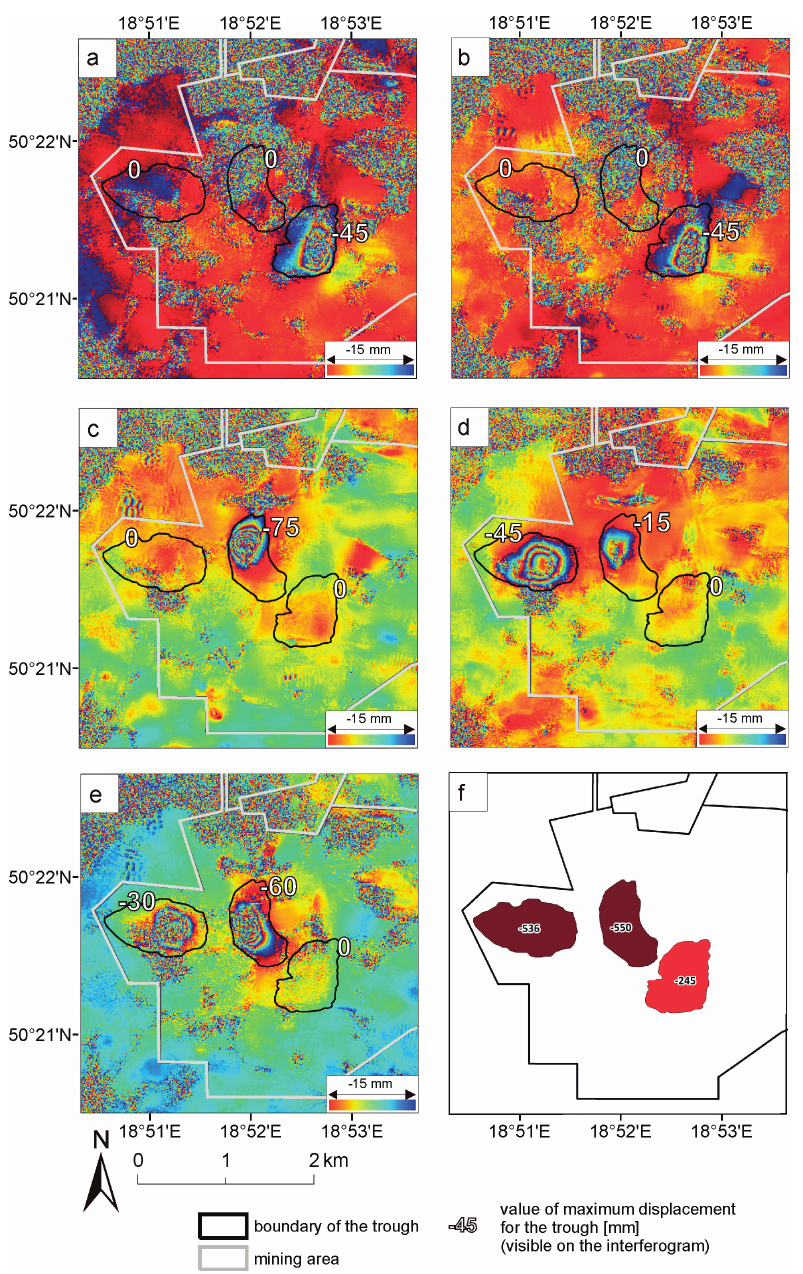
Figure 7. Interferograms (5 out of 28) from Bytom study area: ( a ) 05 July 2011–16 July 2011, ( b ) 16 July 2011–27 July 2011, ( c ) 23 October 2011–03 November 2011, ( d ) 17 December 2011–28 December 2011, and ( e ) 14 March 2012–25 March 2012. ( f ) Summed values of maximum displacement measured for each interferogram generated in the period 05 July 2011–21 June 2012. The values of maximum displacement are reported in the labels over the boundaries of the troughs. Resulting three areas in picture (f) correspond to the troughs labeled 1, 2 and 3 on Figure